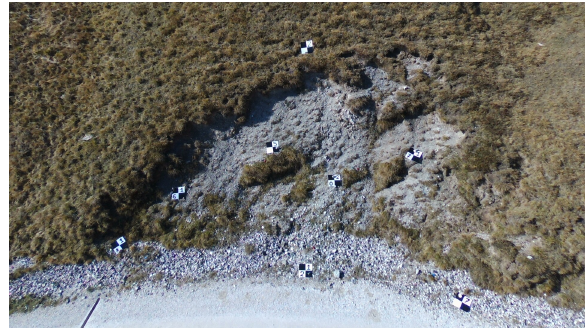
Figure 2. Drone view of the case study area.